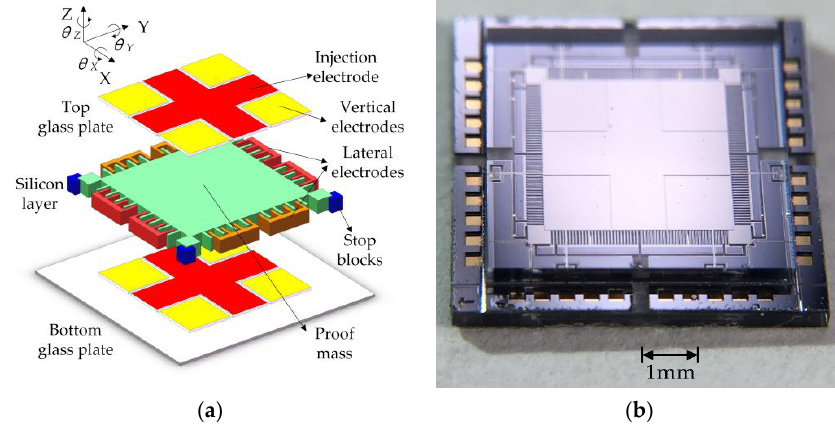
Figure 1. A glass/silicon/glass bonded structure of the MESA device: ( a ) three-dimensional exploded view; and ( b ) a close-up view of the fabricated